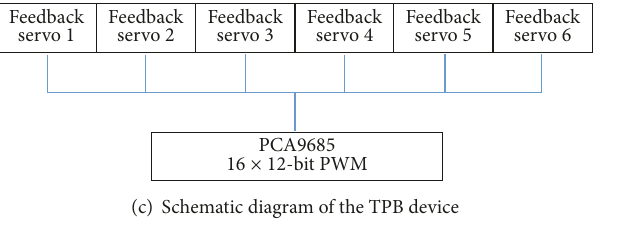
Figure 1: The Teach and Playback device. (a) 6DoF Robot Arm. (b) Fritzing circuit diagram. (c) Fritzing block